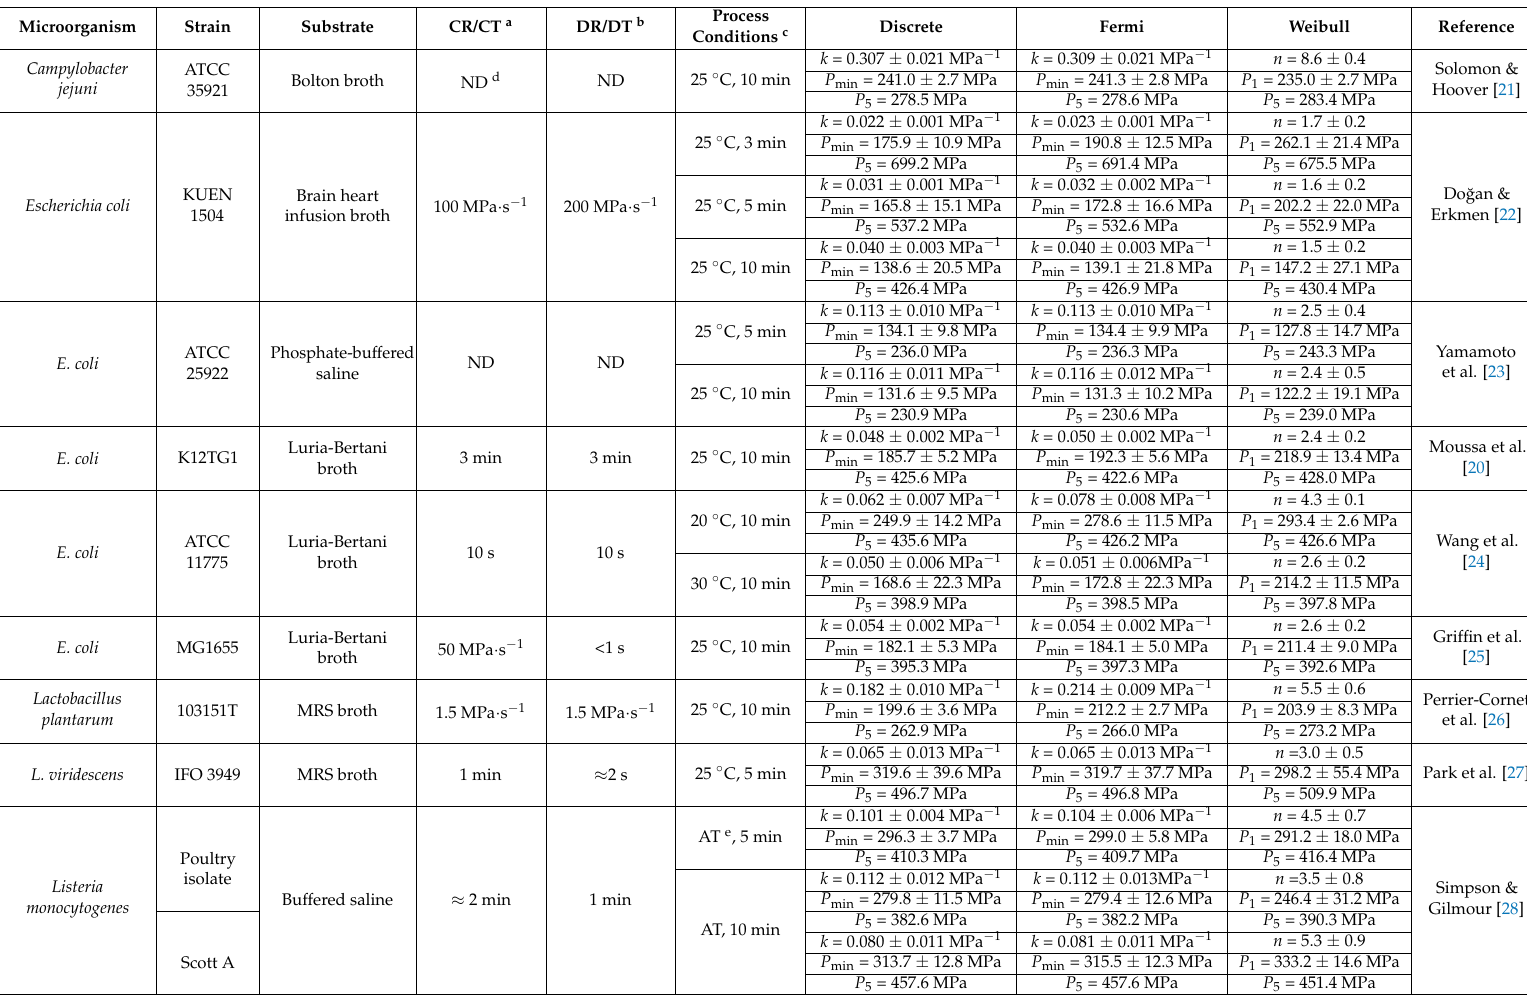
Table 2. Parameters and P 5 values of the Discrete, Fermi, and Weibull models applied to microorganisms exposed to high hydrostatic pressure (HHP) in laboratory